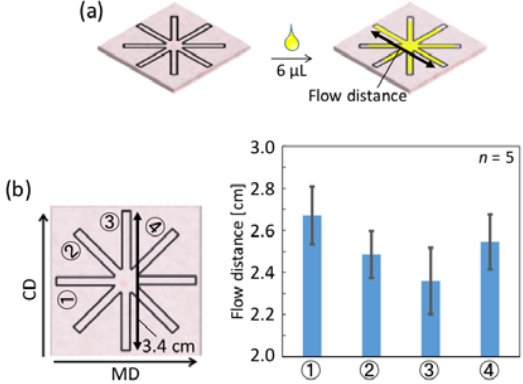
Figure 2. ( a ) Schematic representation of the evaluation of the influence of cellulose fiber direction on sample wicking in patterned filter paper (channel width: 553 ± 31 µm ( n = 20) after lamination). The flow distances are measured as indicated by the arrow. ( b ) Quantitative results averaged for 5 independently fabricated devices (mean value ± 1σ). Circled numbers indicate the respective flow direction.